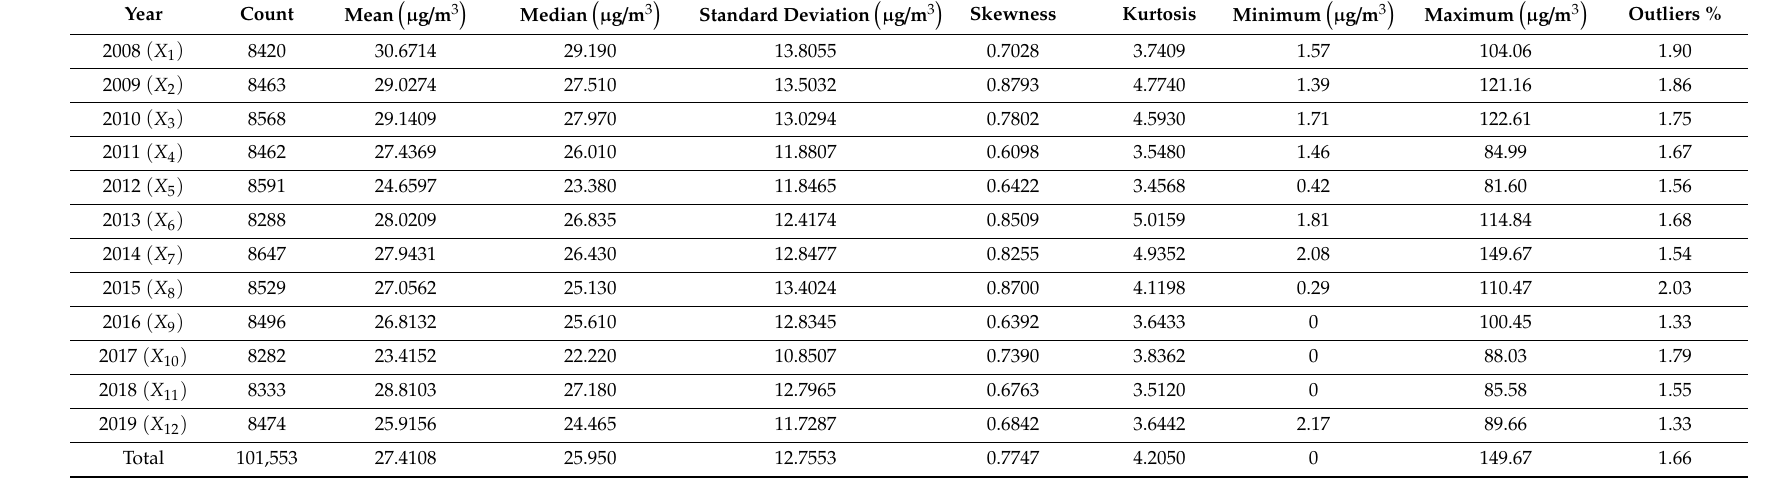
Table 1. Summary statistics of the NO 2 concentration